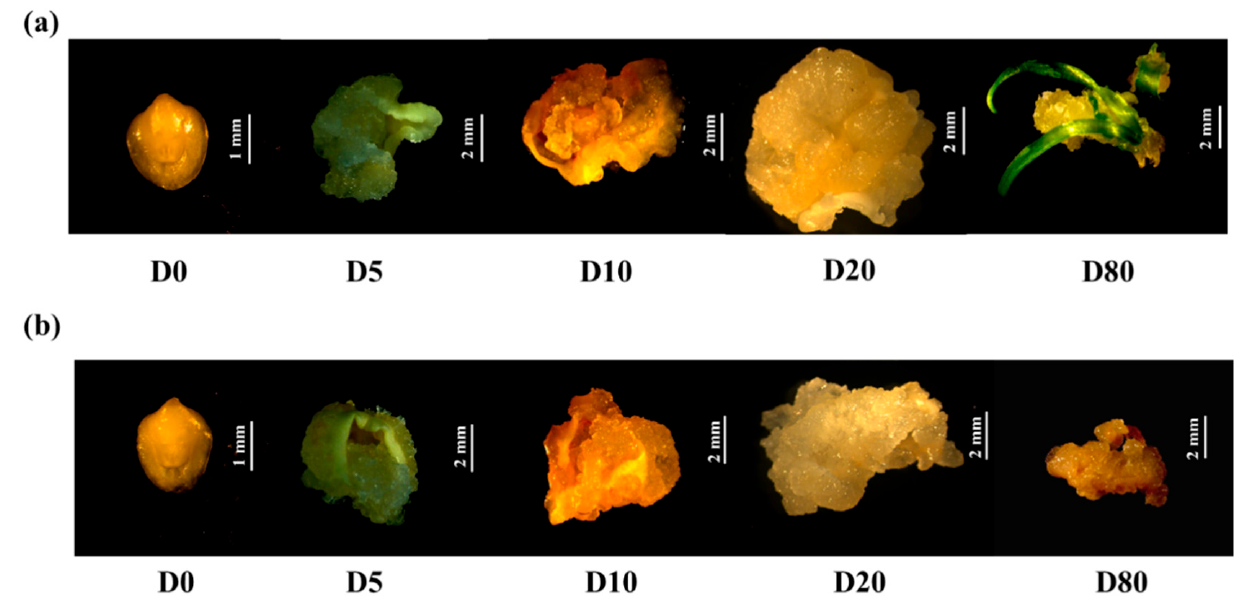
Figure 1. Callus morphology of the two barley genotypes at 0, 5, 10, 20, 80 days after tissue culture. ( a ) GP. ( b ) ZU9. D0, day 0; D5, day 5; D10, day 10; D20, day 20; D80, day 80.